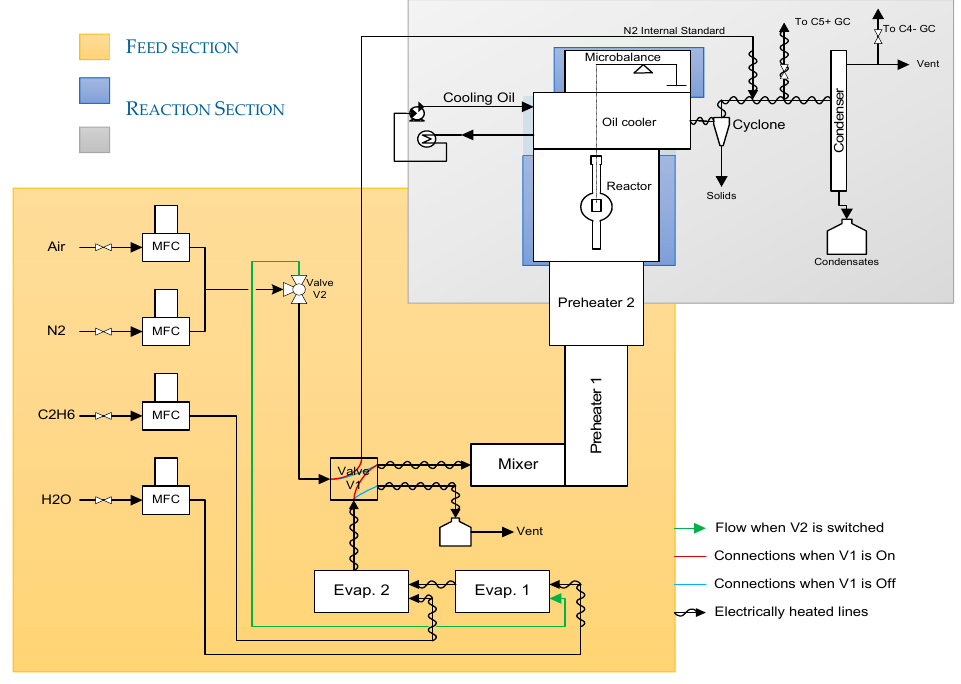
Figure 1. Schematic representation of the JSR set-up .